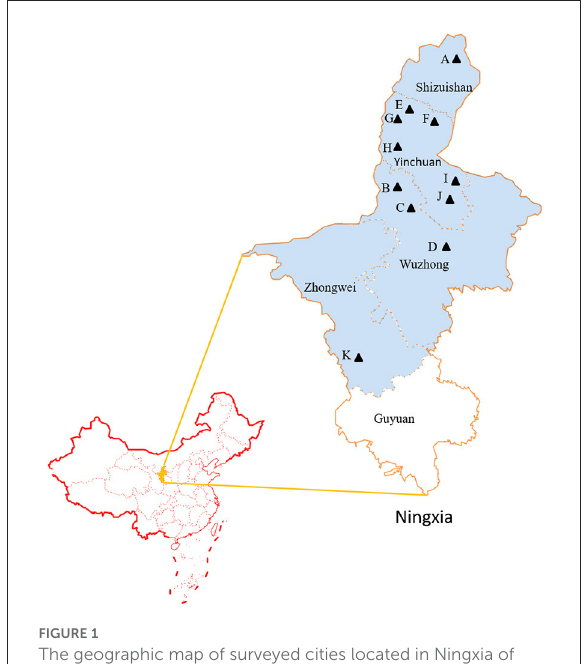
FIGURE1 The geographic map of surveyed cities located in Ningxia of China. (A-K) The samples collected areas are indicated with black